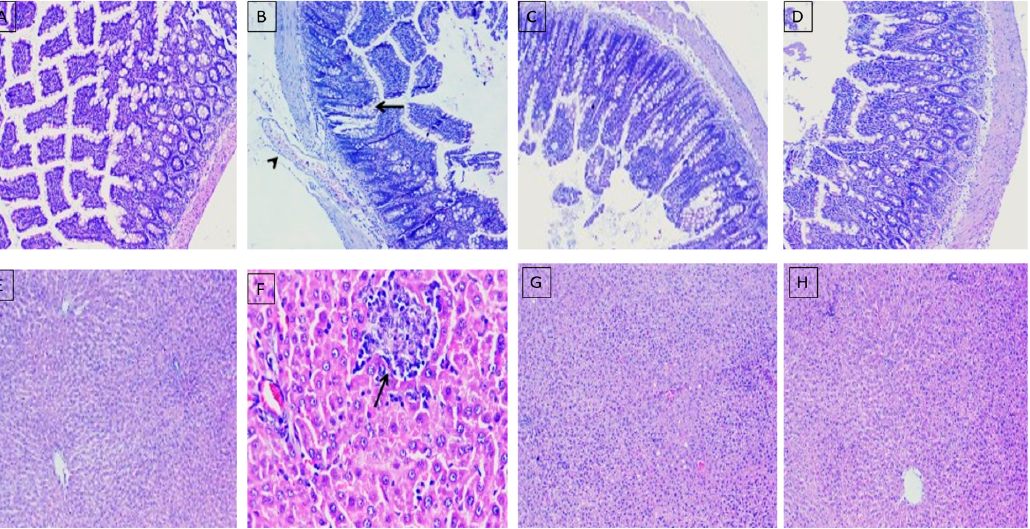
Figure 6. Representative photomicrographs using H&E staining of histological sections for intestines ( A – D ), and livers ( E – H ) of rats treated with CIP–MSN compared with CIP alone at 14 days